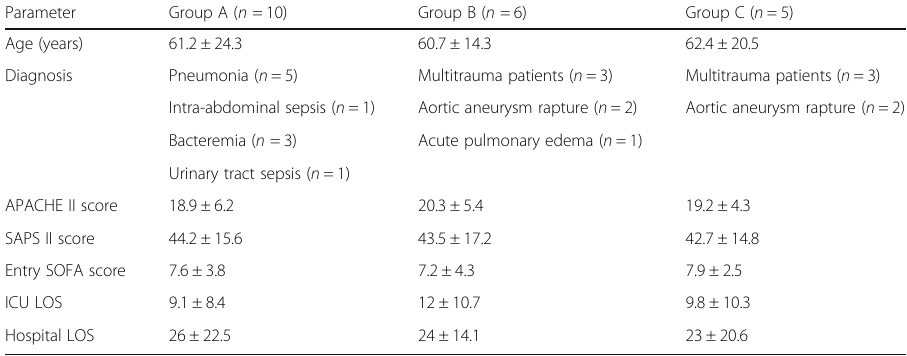
Table 1 Patients ’ characteristics